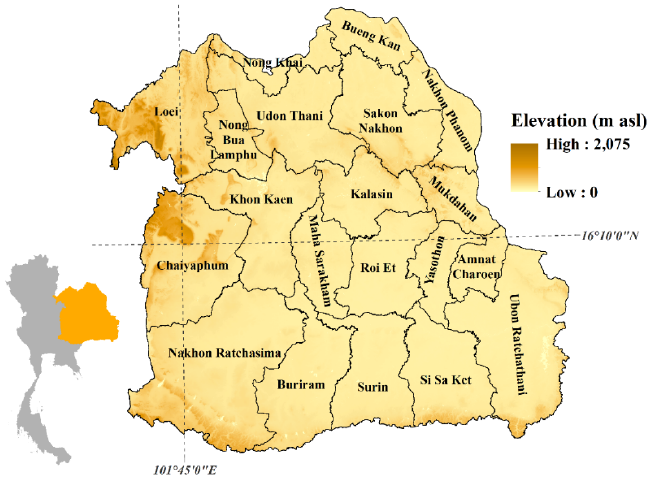
Figure 1. Topography of Northeast Thailand .